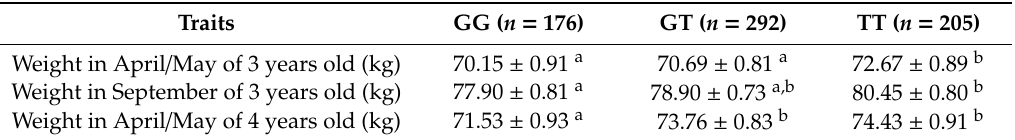
Table2. Associationof SPAG8rs160159557 (G493C)associationwithewematureweights,showingadjusted means and standard errors from Rambouillet, Polypay, and Targhee